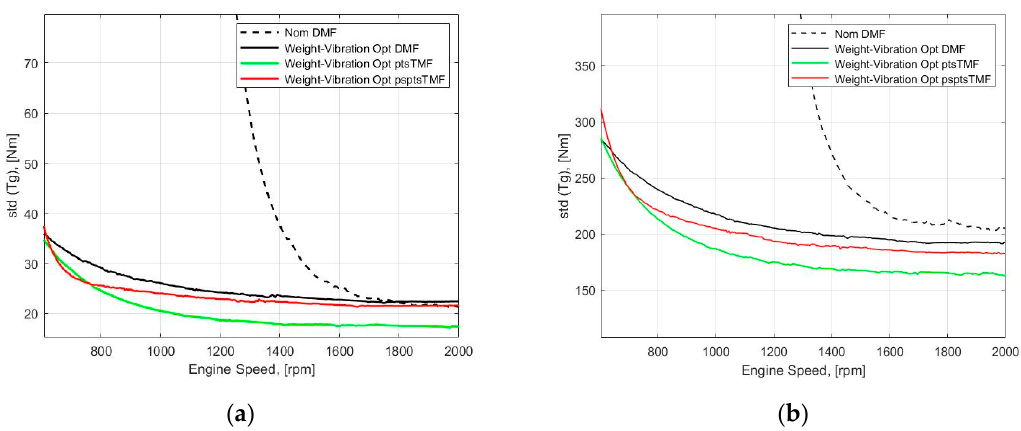
Figure 5. Zoomed plots of the engine speed history of the standard deviation of the torques at the transmission input shaft for the DMF with nominal values of design parameters (12) and for optimized vibration absorbers: ( a ) for T m = 300 Nm, a e = 500 Nm; ( b ) for T m = 3000 Nm, a e = 3000 Nm.